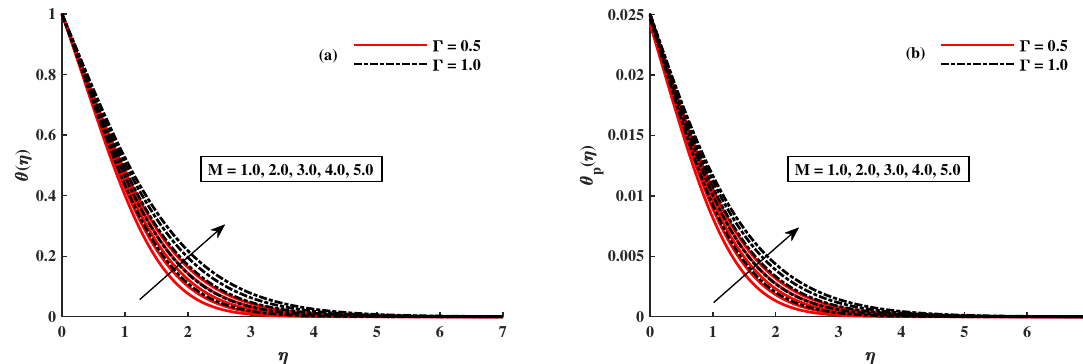
Figure 3. Variation of M to influence the fluid and dust temperature profile.